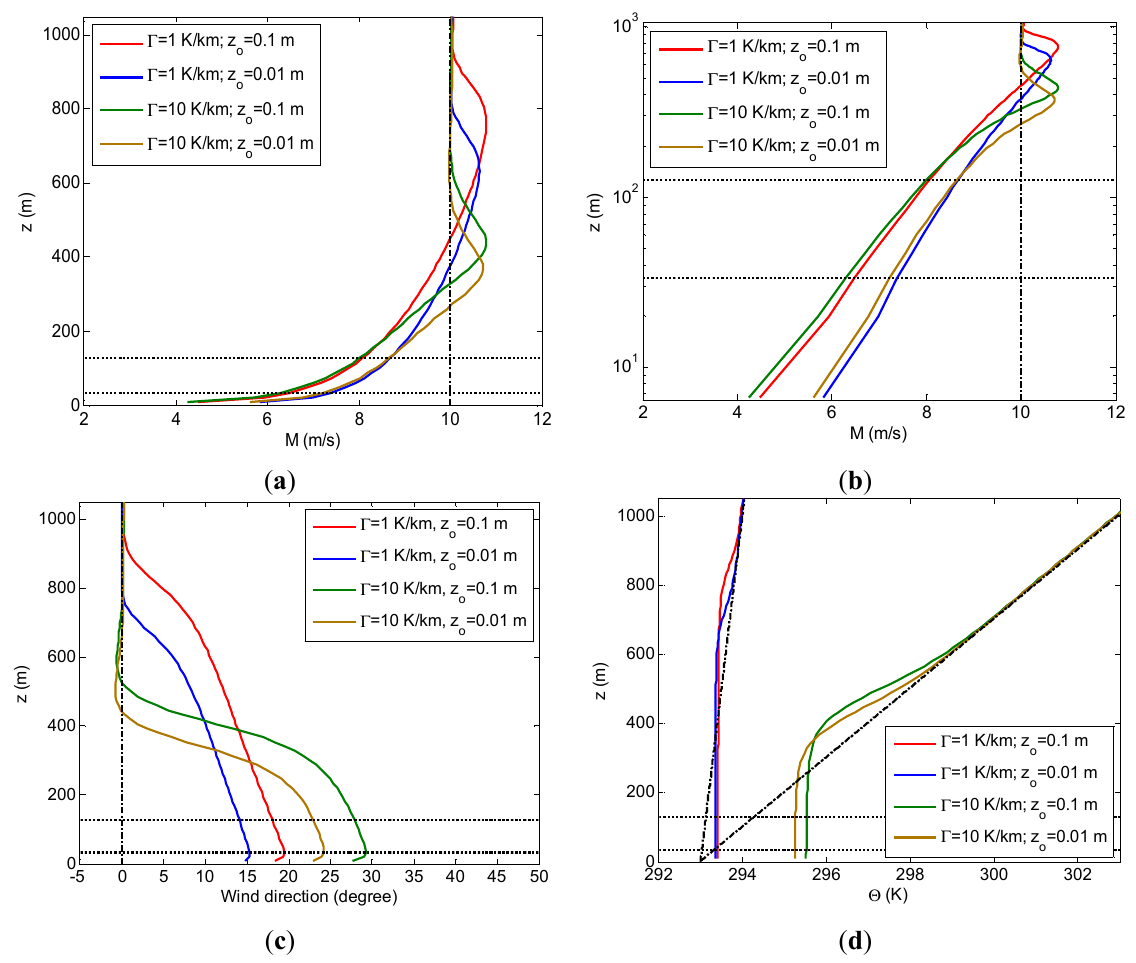
Figure 2. Vertical profiles of horizontally-averaged velocity magnitude M in ( a ) linear scale; and ( b ) semi-log scale; ( c ) wind direction; and ( d ) horizontally-averaged potential temperature ( Θ ) inside the ABL for two different values of Γ and z lines show the top-tip and bottom-tip